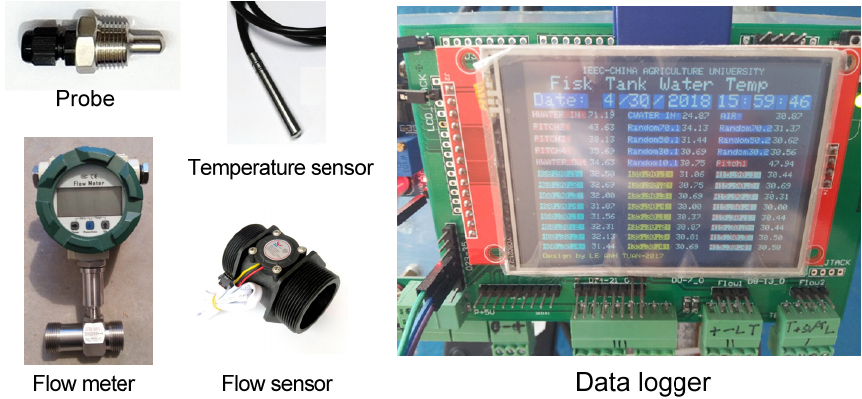
Figure 8. Instrumentation for the experimental setup.